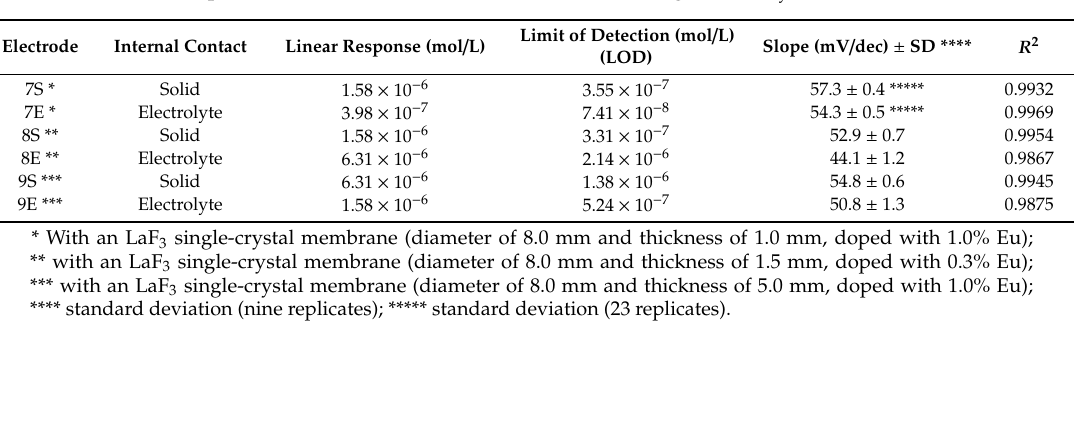
Table 3. The response characteristics of electrodes after washing the Fe x O y NPs out from